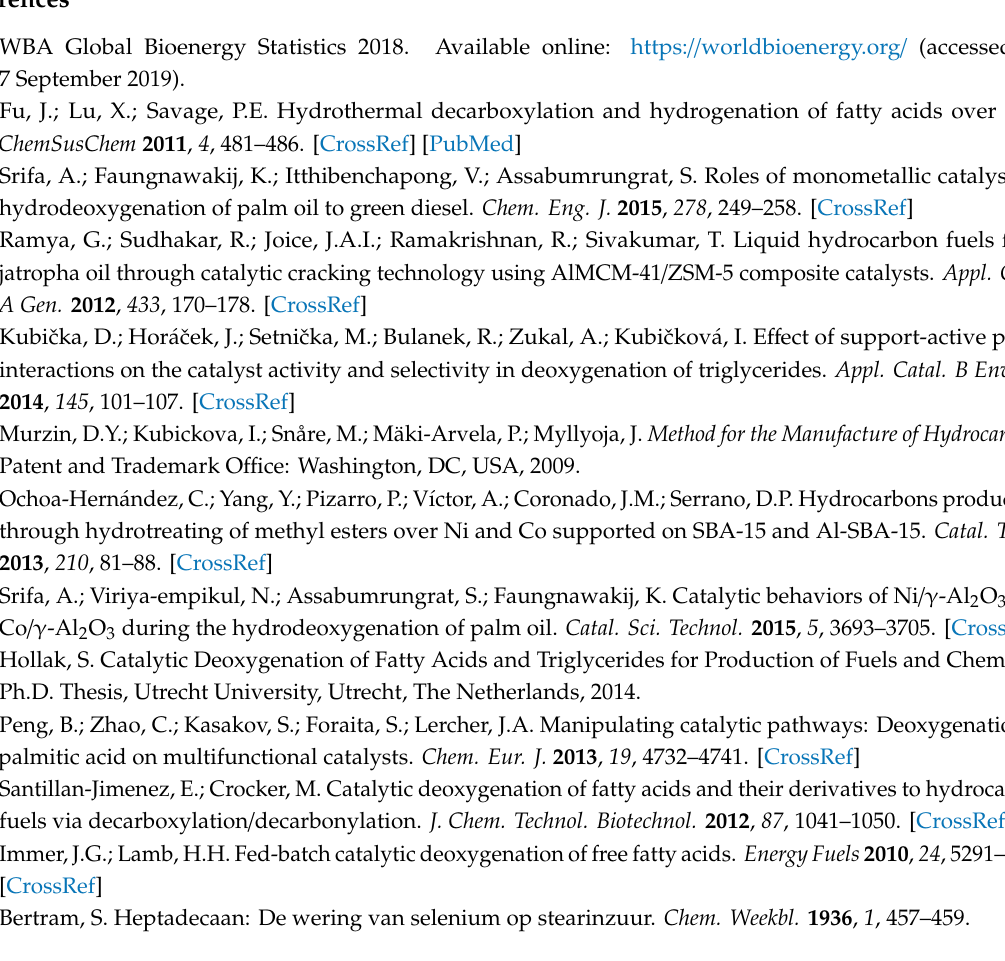
Figure S1: Representative GC / MS chromatogram; Figure S2: XPS Pt 4f spectra for Pt-based catalysts after reduction treatment; Figure S3: XRD of activated and spent Pt / N-AC catalyst; Table S1. Composition of C8–C18 liquid products; Table S2: Textural properties of the